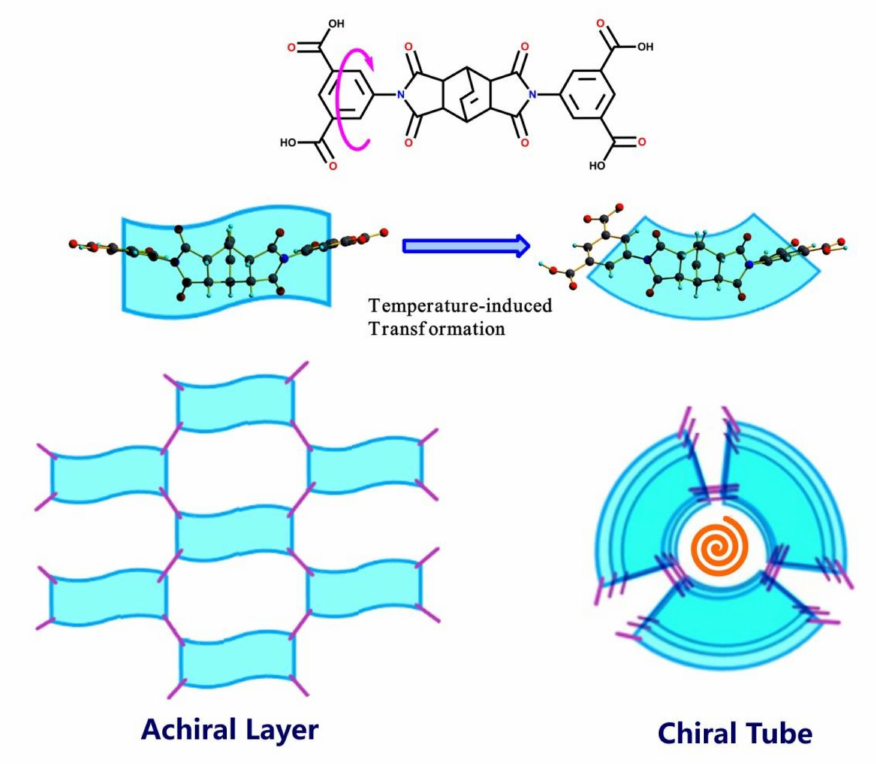
Scheme 2. The supramolecular isomeric transformation derived from the ip segments torsion of semi-rigid tetra-acid